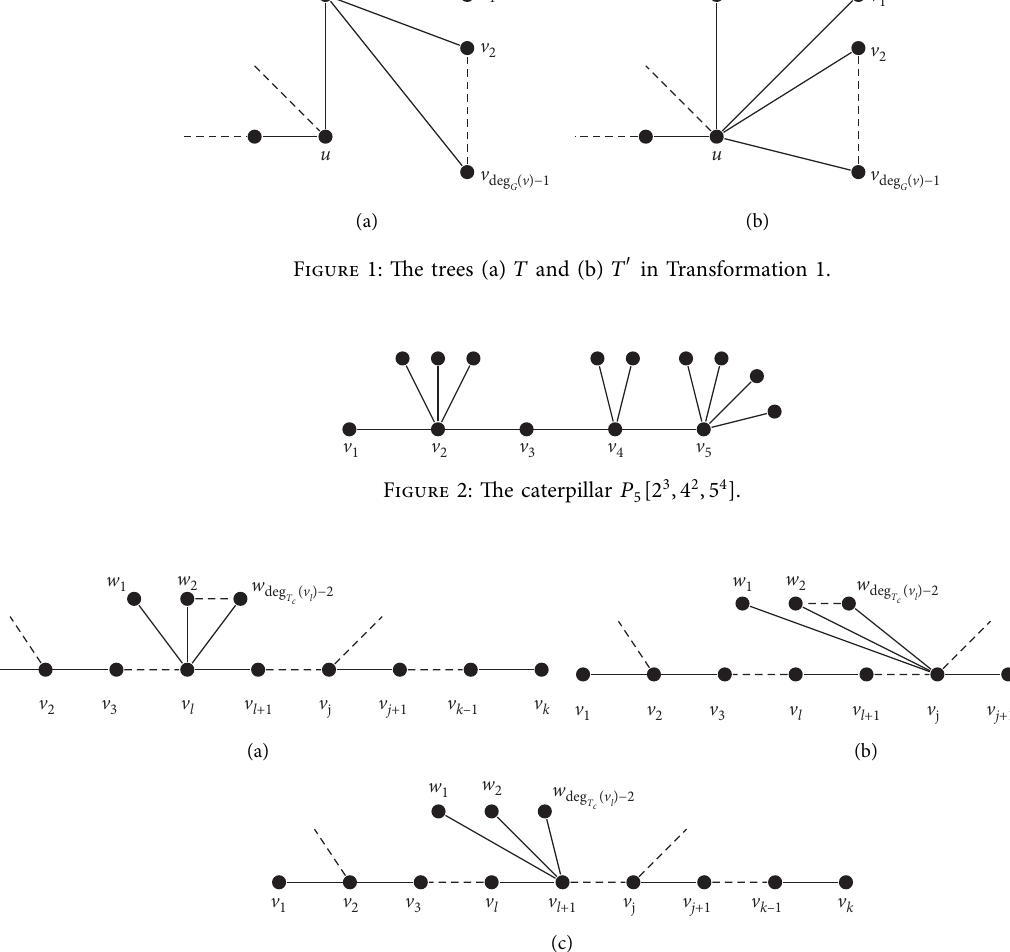
Figure 3: The trees (a) T